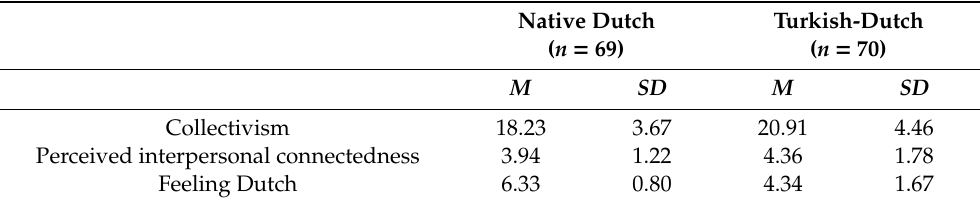
Table 4. Means and standard deviations on cultural-related variables in Study 2.